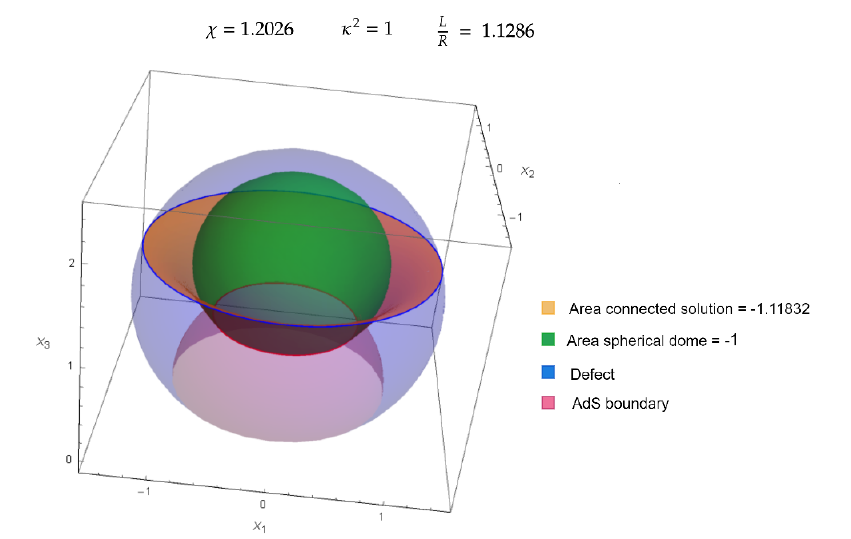
Figure 1. The projection of the minimal surface in AdS 5 is entirely contained in a sphere S 3 (see appendix E). In this plot this sphere is mapped into R 3 through the usual stereographic projection. The blue spherical cap is the intersection between S 3 and the D5 while pink one is the intersection between S 3 and the boundary of AdS 5 . Then, the green dome and the yellow surface connecting the boundary with the D5 are the two competing solutions. For this choice of parameters the dominant solution is the connected